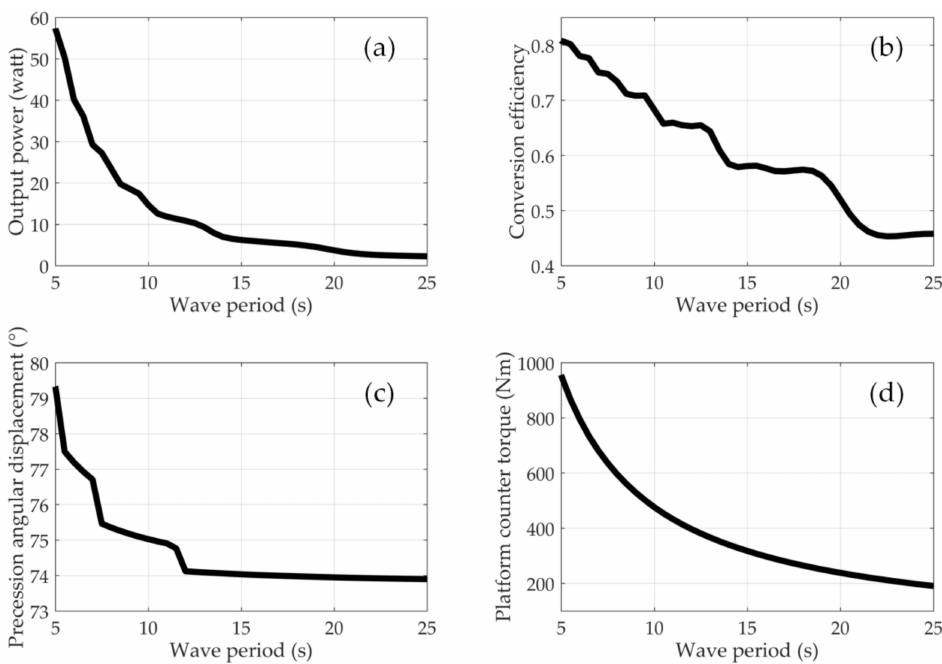
Figure 12. Effect of the wave period: ( a ) output power; ( b ) conversion efficiency; ( c ) flywheel precession angular displacement; ( d ) platform counter